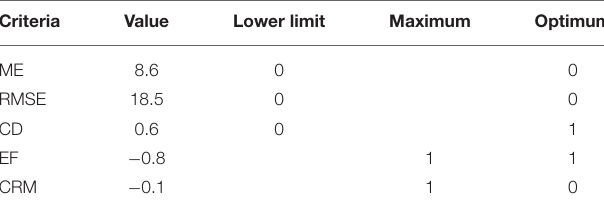
TABLE 5 | Result of model performance evaluation according to Loague and Green (1991).